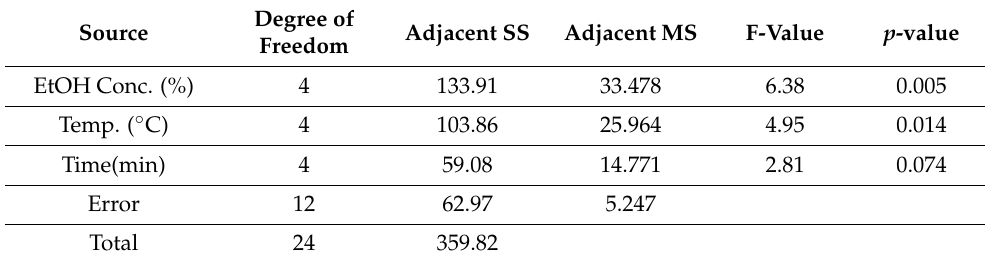
Table 6. ANOVA for EtOH solvent